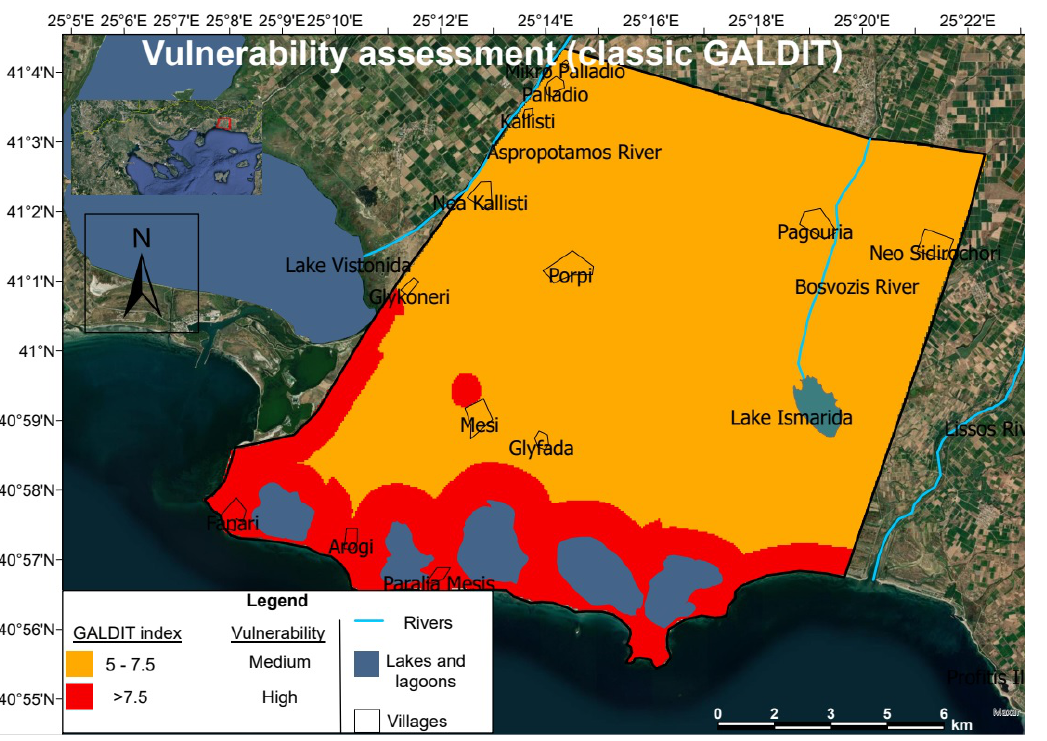
Figure 7. Thematic maps for the type of the aquifer (G) ( left ) and the hydraulic conductivity (A) ( right ) for the modified GALDIT method. The target aquifer is the uppermost semi-confined, which suffers from extended sal- inization phenomena (Figure 7, left). The hydraulic conductivity is generally low to me- dium due to the interbedded layers of clay, which have a significant thickness in specific areas (e.g., West of Ismarida lake) (Figure 7, right).